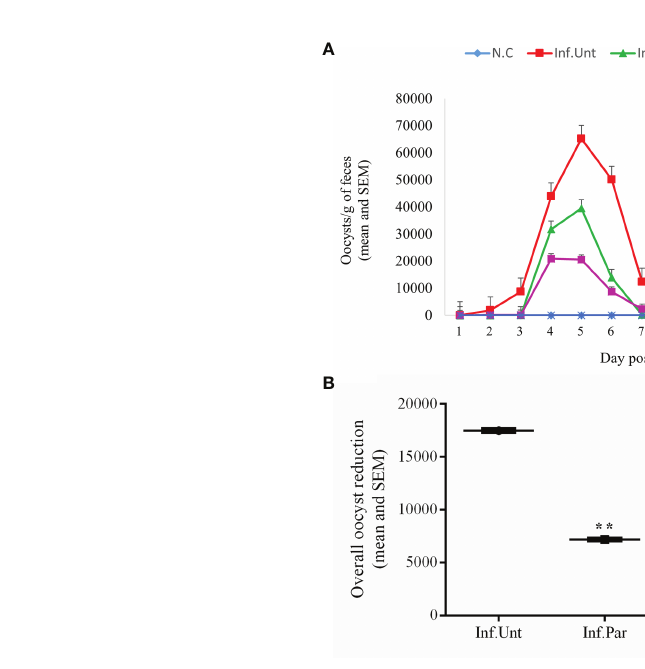
FIGURE 1 | Cryptosporidium parvum oocyst shedding pattern. (A) Infection intensity in different groups during treatment days. C . parvum infection was established by oral gavage of ∼ 10 6 C . parvum oocysts followed by oral treatment with the indicated dose of chitosan or paromomycin (positive control). Lines and dosing regimen are color coded as follows: blue line (normal control); red line (infected + untreated); green line (infected + paromomycin treated 50 mg/kg/day); purple line (infected + chitosan treated 1 mg/kg/day); darker blue line (uninfected + chitosan treated 1 mg/kg/day). (B) Overall oocyst reduction rate between Inf.Unt, Inf.Par, and Inf.Chit treatment groups. Data are the mean ± SEM of three independent tests. ** p < 0.01 statistical difference comparison of the Inf.Unt group with Inf.Par and Inf.Chit